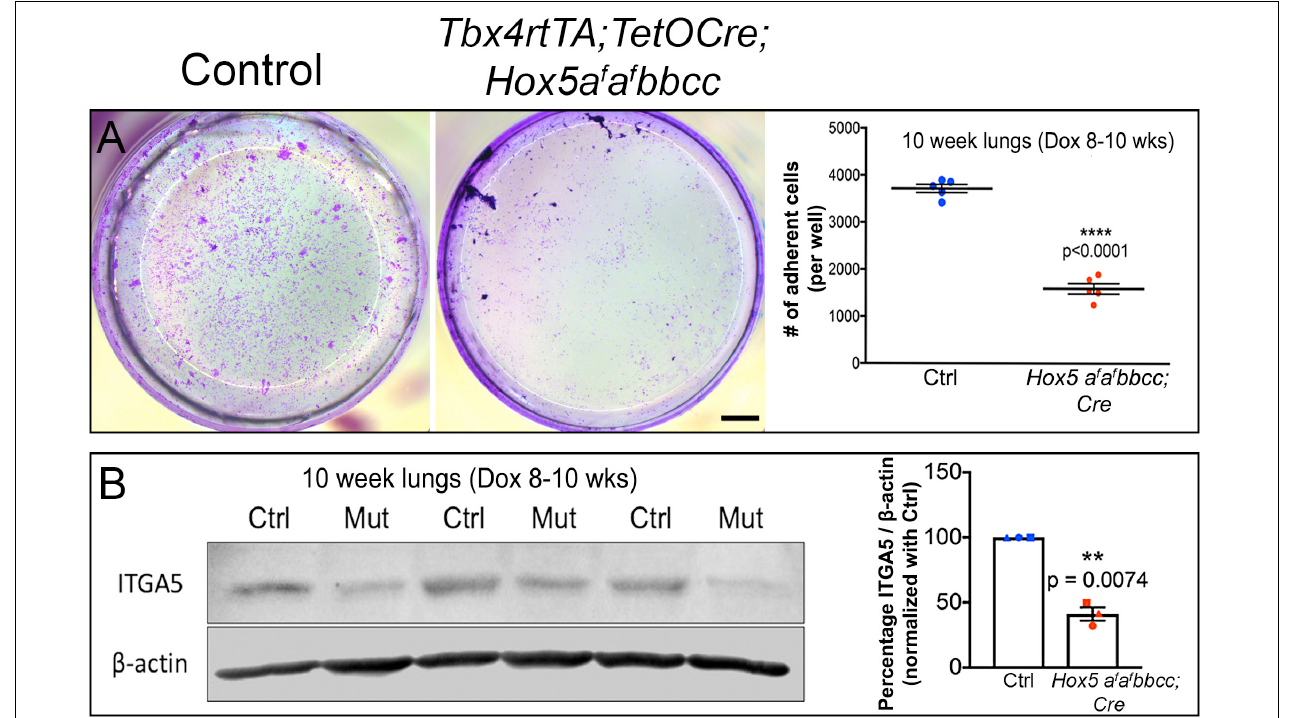
FIGURE 6 | Hox5 adult, mutant lung fibroblasts are less adherent in culture compared to controls. Lung fibroblasts were isolated, seeded on fibronectin-coated plates and incubated for 1 h prior to low-gravity centrifugation then fixation. Cells were stained with crystal violet, imaged, then counted. Hox5 adult, conditional mutant stromal cells are significantly less adherent in this assay (A) . Western blotting of protein from right accessory lobes from Hox5 adult, conditional mutant lungs show ∼ 50% lower ITGA5 levels compared to control lung tissues (B) . Each shape represents an individual animal. Scale bar: 10 mm. P -values and statistical significance (**0.001 ≤ P < 0.01; **** P < 0.0001) were determined by an unpaired Student’s t